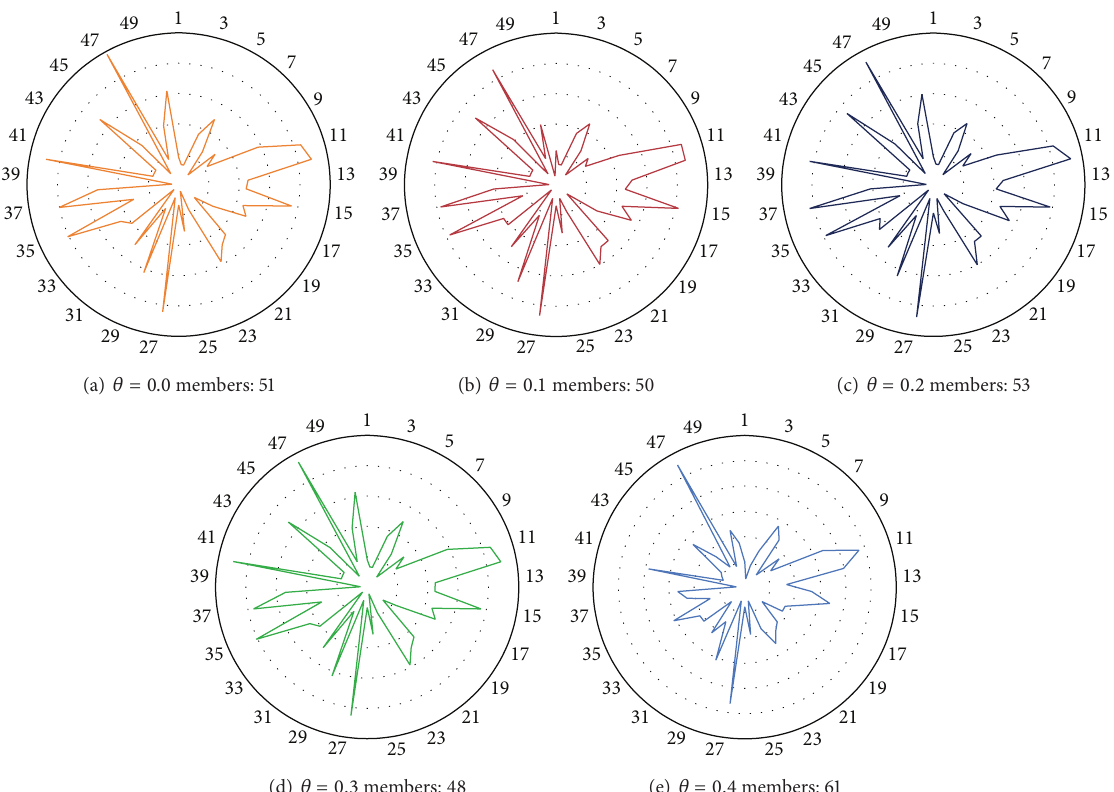
Figure 5: Content community patterns of the largest communities detected through TPA on 2005-VC with several semantic